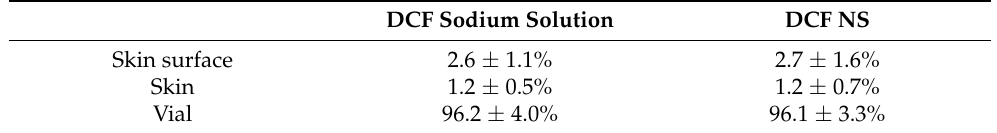
Table 2. DCF recovered on the skin surface, within the skin or below the skin (vial) after jet injection of a DCF sodium solution or DCF NS (pH 6.0) across a skin specimen. Values are expressed as the percentage of the DCF dose injected. Results are the average of n = 3 independent determinations.